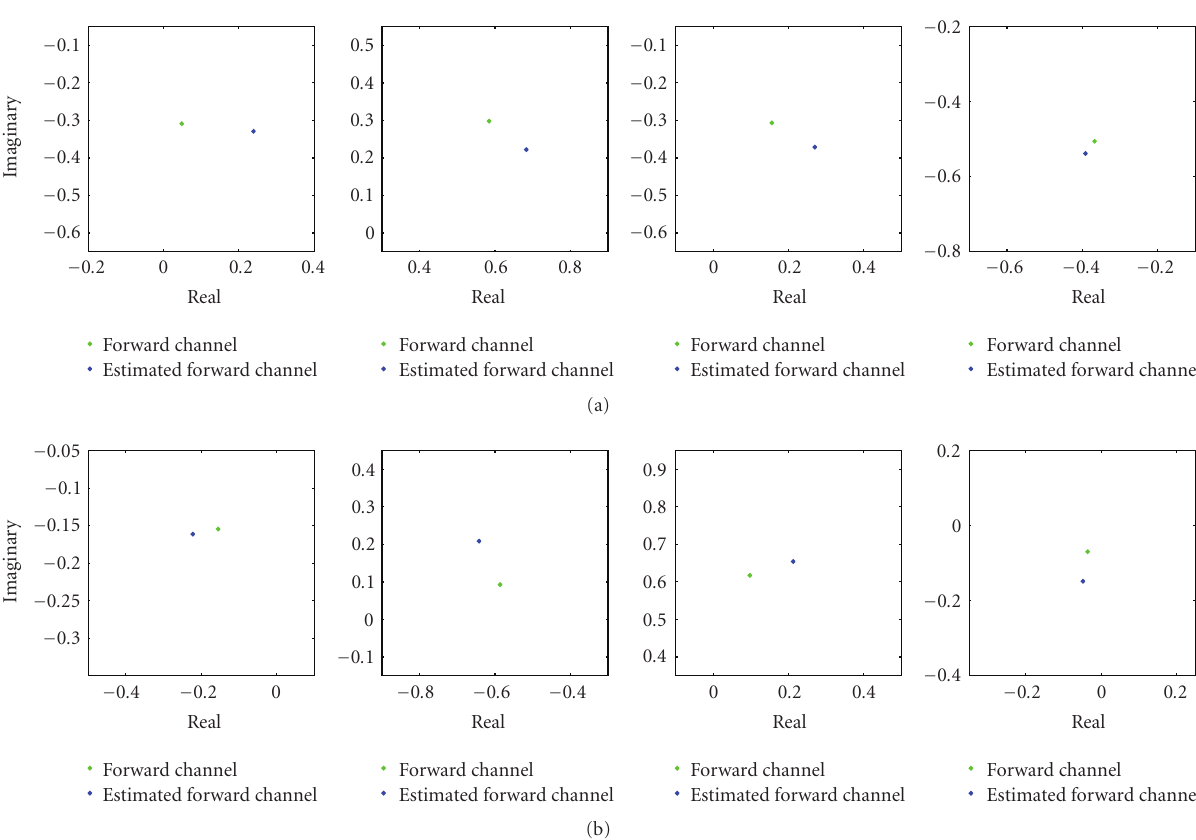
Figure 5: Comparison example between forward and estimated forward channels at Location